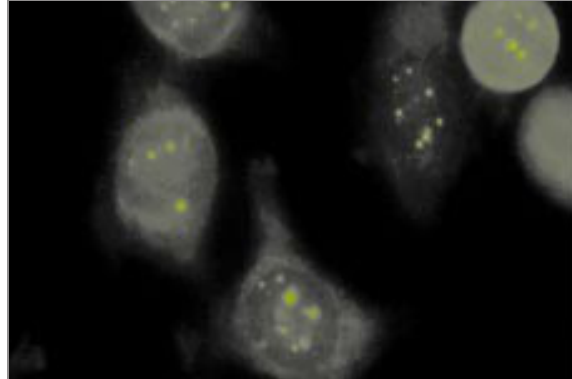
Figura 5 – Nuclear pontilhado do tipo pontos isolados